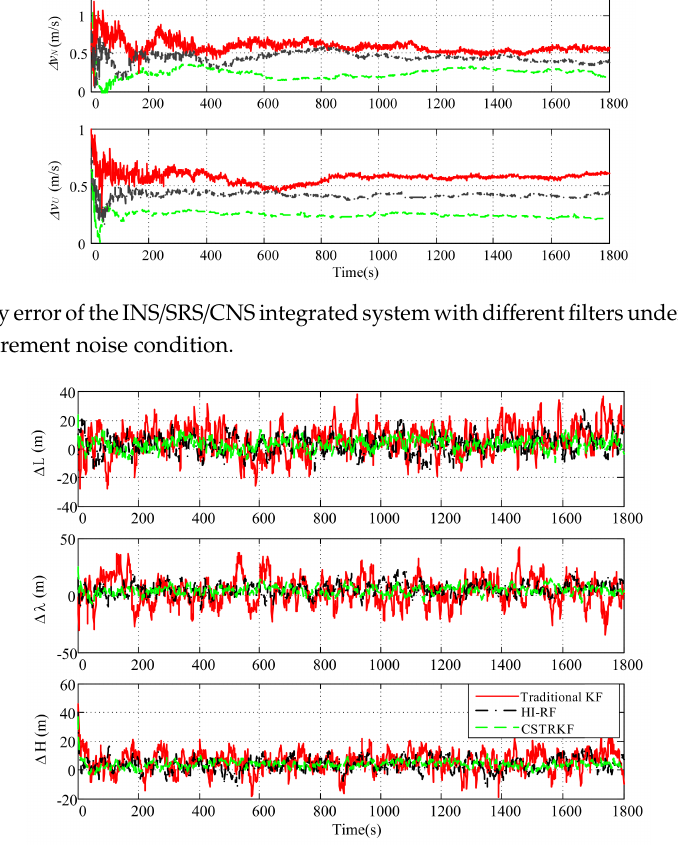
Figure9. PositionerroroftheINS / SRS / CNSintegratedsystemwithdi ff erentfiltersunderacontaminated Gaussian measurement noise condition. Table 3. MAEs of estimation under the contaminated Gaussian noise